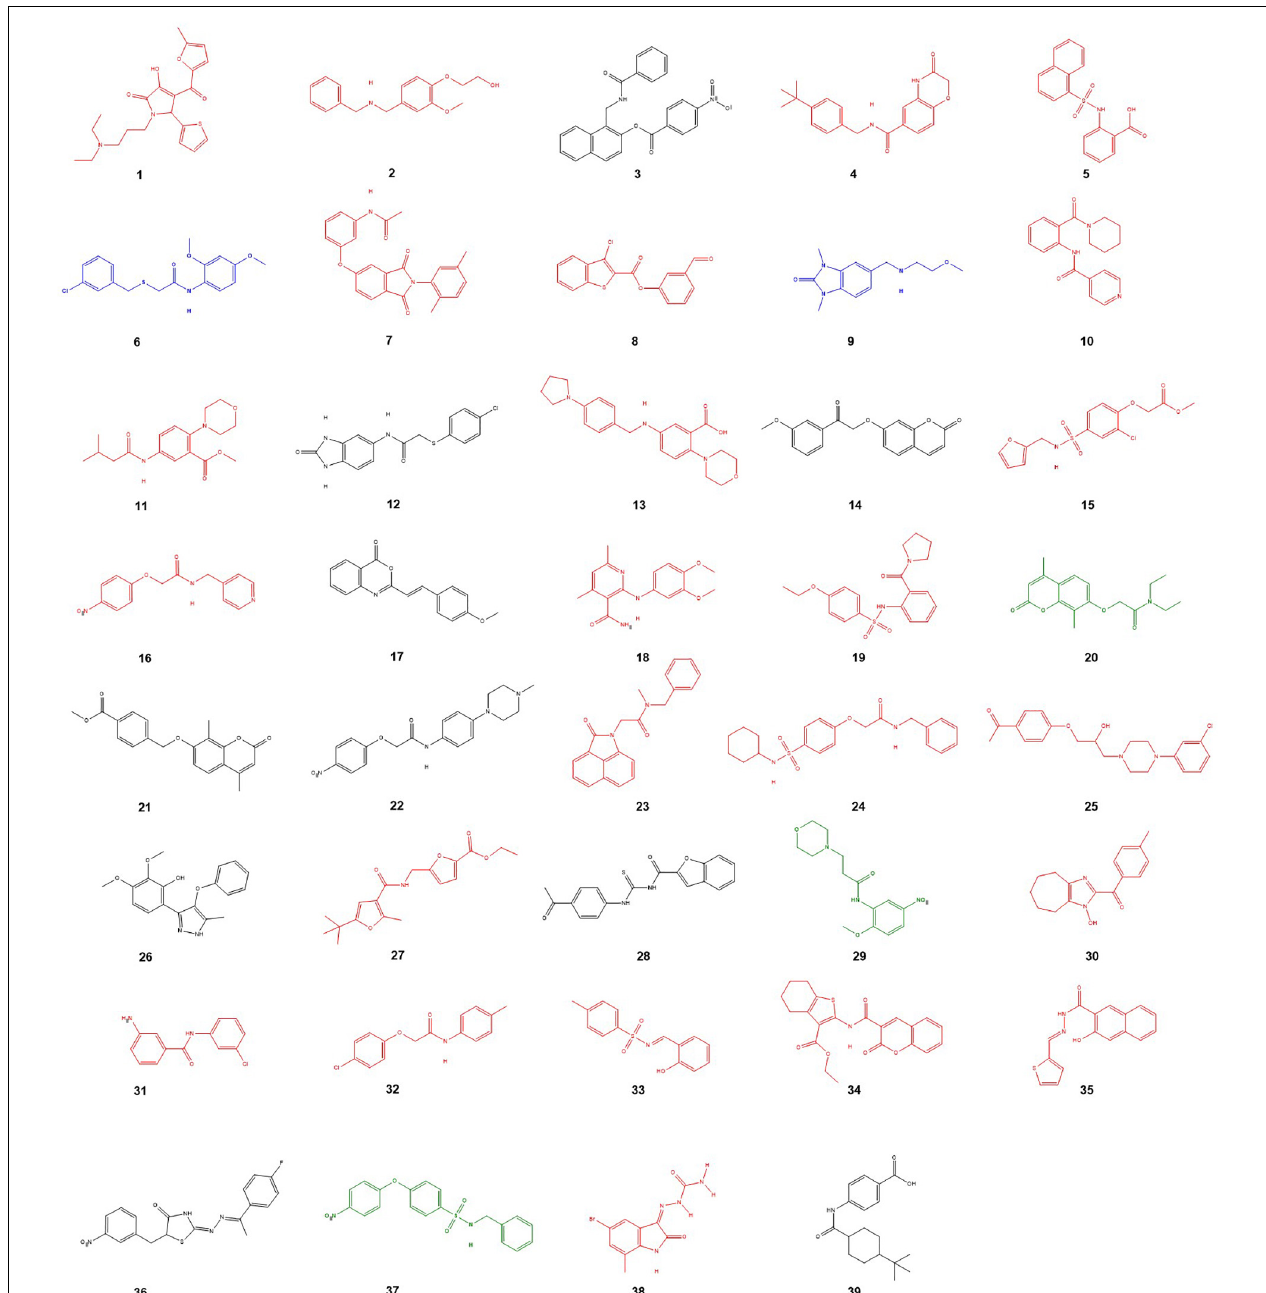
FIGURE 1 | Structures of the compounds selected for the first in vitro screen. Compounds in black were too insoluble for in vitro testing. Red compounds were inactive. Weakly active compounds (6,9) are blue and moderately active compounds (20,29,37) are displayed in green.